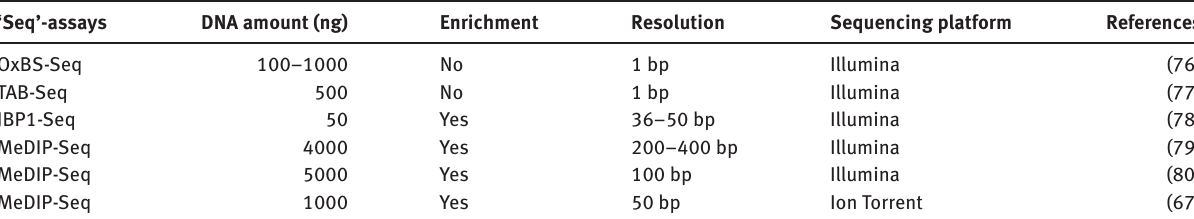
Table 1: Genome-wide sequencing methods targeting 5-hmC modifications.